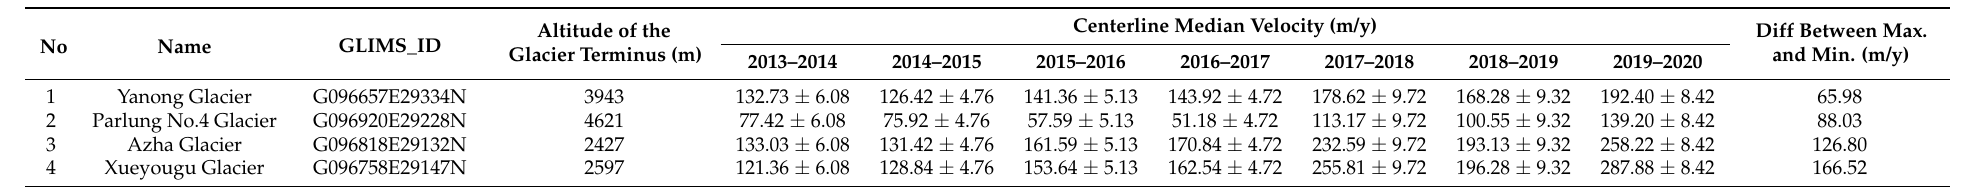
Table 3. Annual (Image pair covering from October to October the following year) median centerline velocity of the four glaciers in the Parlung Zangbo Basin from 2013 to 2020; accuracy is estimated using samples in the entire off-glacier portion of our study area (see Section 3.3 for